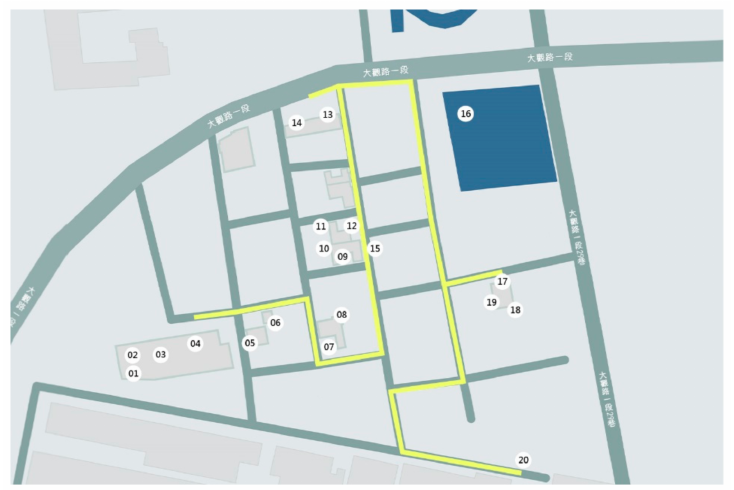
Figure 5. Locations of artworks and suggested route (The numbers in the figure are the artwork